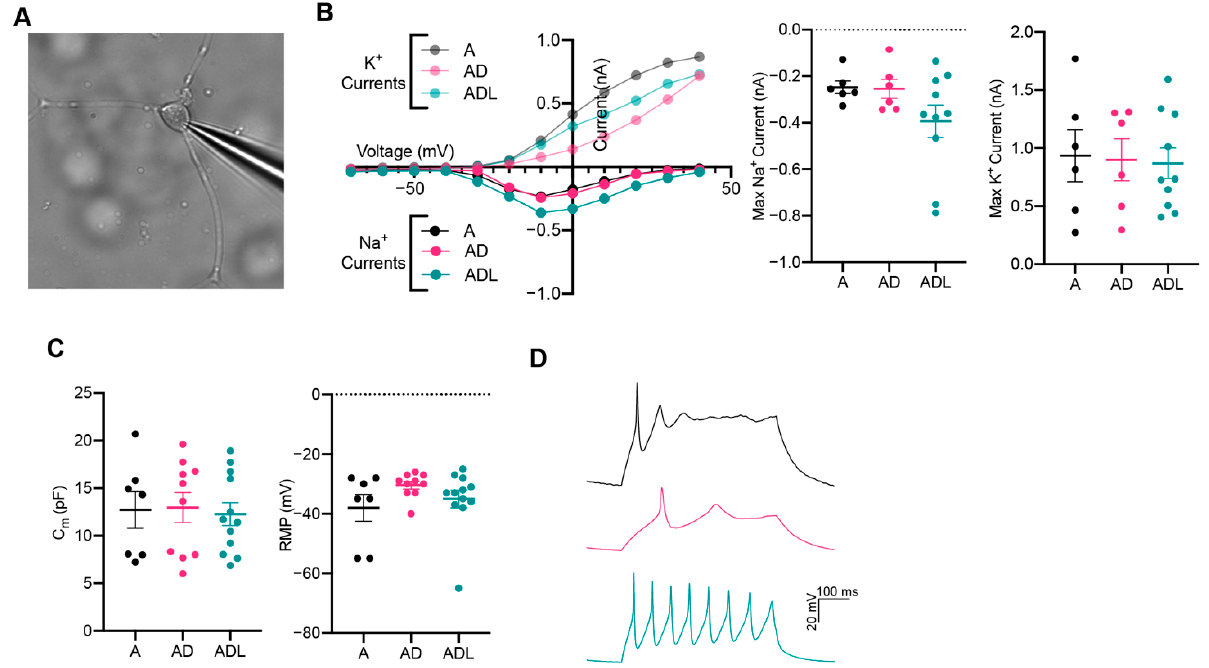
Figure 4. Functional analysis of induced neurons converted with A, AD or ADL at day 25. ( A ) Representative image of iN in whole-cell patch-clamp configuration. ( B ) Inward Na+ and outward K+ currents plotted against stepwise voltage induction at day 25: A (black), AD (magenta/pink) and ADL (green/light green); with each dot representing a mean value ( n = 5 for A, n = 6 for AD and n = 10 for ADL). ( C ) Intrinsic membrane properties, capacitance (left) and resting membrane potential (RMP) (right). ( D ) Representative trace of immature evoked action potentials triggered by rheobase current injection steps: A (black), AD (magenta) and ADL (green).